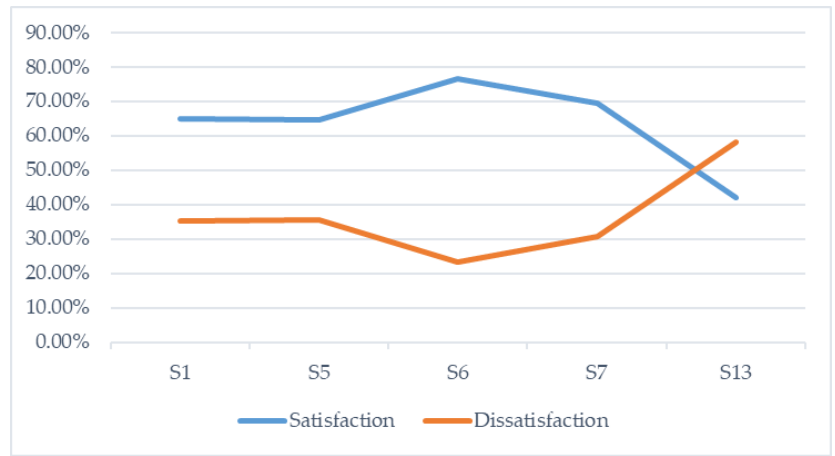
Figure 1. Evolution of the perceptions of satisfaction and dissatisfaction in the analyzed sessions of the teaching-learning gymnastic process.